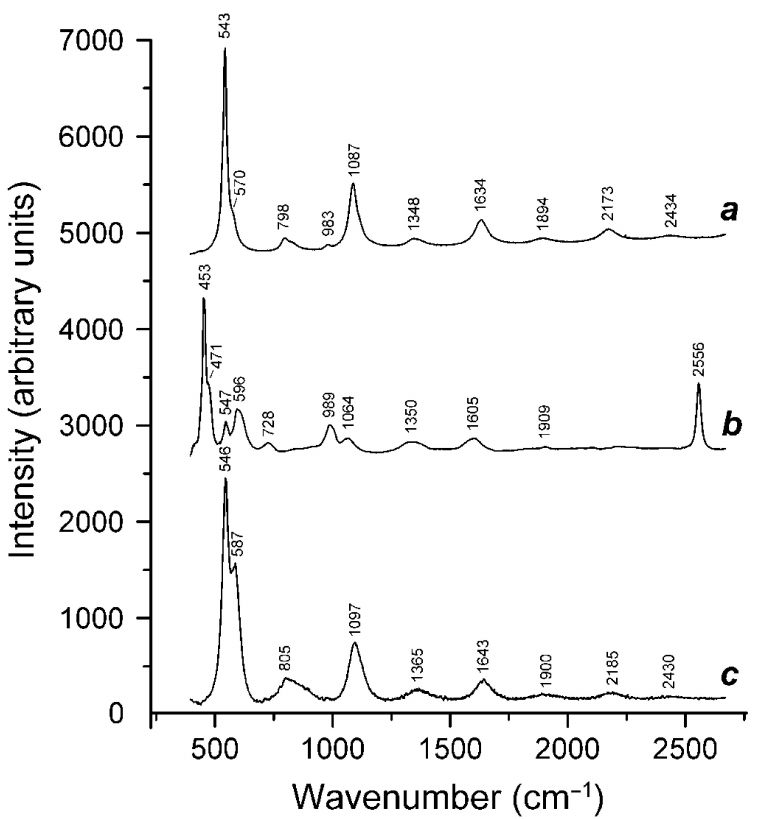
Figure 13. Raman spectra of ( a ) initial S 4 -bearing haüyne (Sample 5), ( b ) Sample 5 preheated for three days at 700 ◦ C, over the Fe-FeS buffer and ( c ) preheated Sample 5 additionally annealed at 800 ◦ C in air for one day.